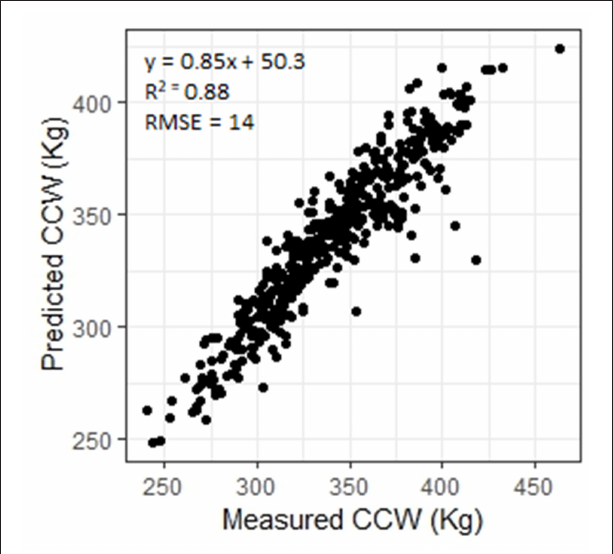
FIGURE 3 | Measured cold carcass weight (CCW) plotted against CCW predicted using an artificial neural network.